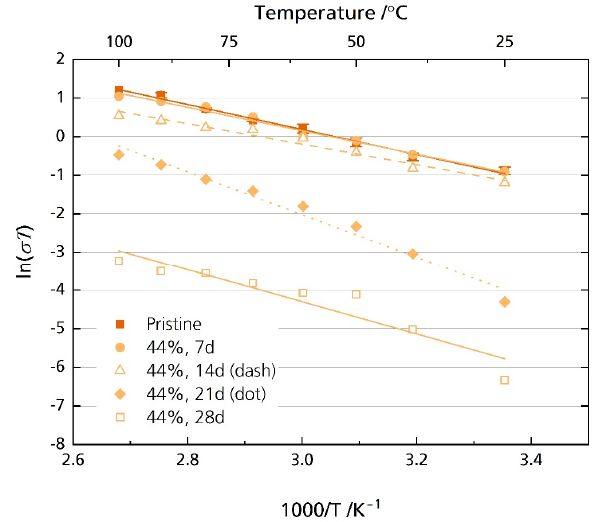
Figure 11. Arrhenius plot of the pristine sample and the specimens stored in 44% r.h for 7, 14, 21, and 28 days considering the whole frequency range.